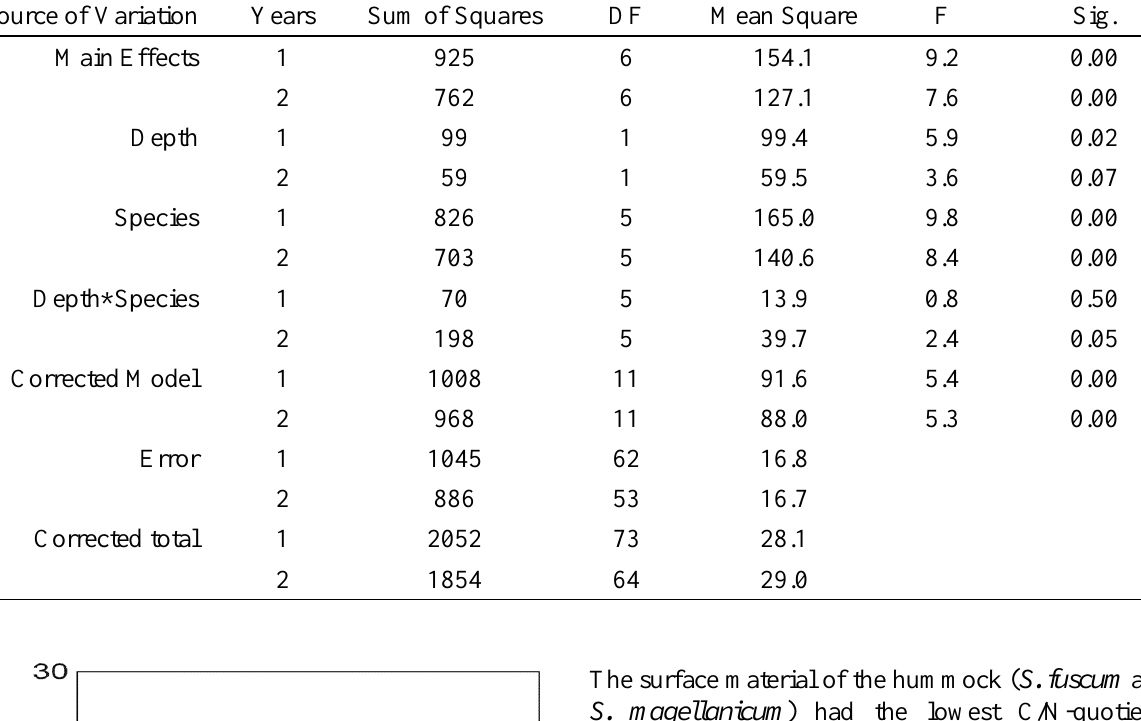
Table 2. Two-way analysis of variance for percentage mass losses after one and two years from Sphagnum litter bags placed at intermittently anoxic and anoxic levels within hummock, lawn and hollow microhabitats. Source of Variation